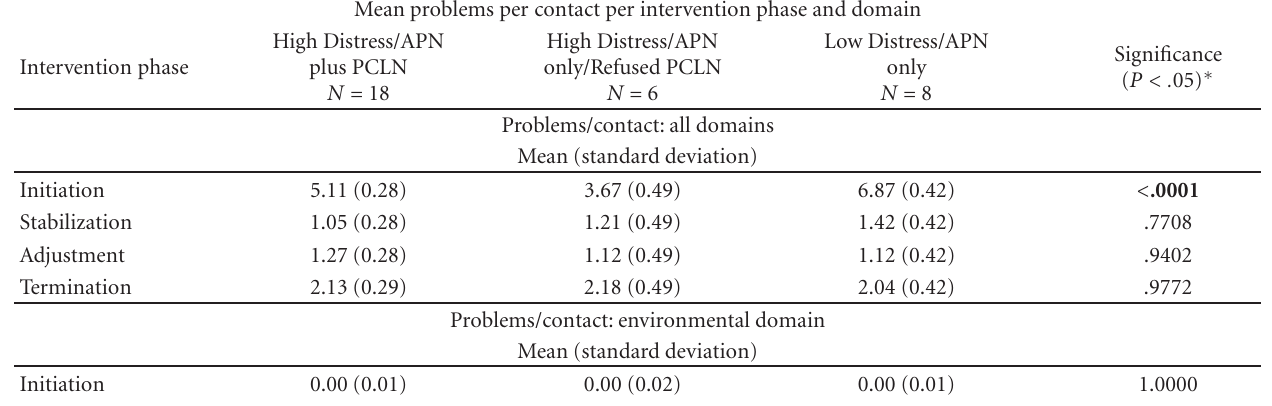
Table 2: Mean total problems per contact and within each Omaha System Problem Domain, by intervention phase and subsample. Mean problems per contact per intervention phase and